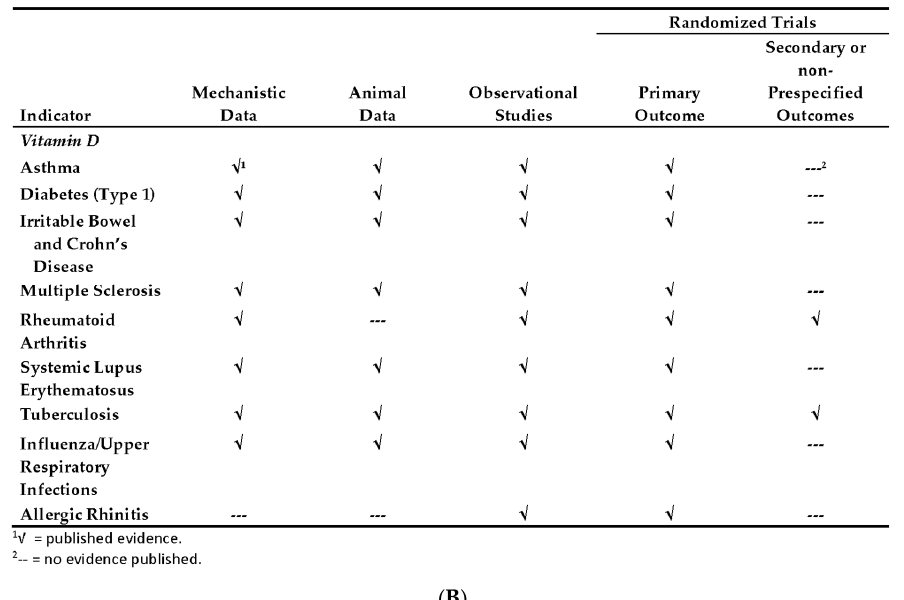
Figure 1. Illustration of data arrays to evaluate totality of the evidence. ( A ) Forest plot for colon cancer risk stratified by vitamin D concentration (from Chung et al., 2009 [8], Figure 9); ( B ) Evidence map for vitamin D and immune outcomes (modified and updated based on IOM, 2011 [3], Table E-5; reproduced with permission). Abbreviations: WCC = Washington County Cohort, Women’s Health Initiative; PHS = Public Health Centers; HFPS = Health Facilities Program Section; ATBC = α -Tocopherol, β -Carotene Cancer Prevention Study; NHS = National Health Survey.